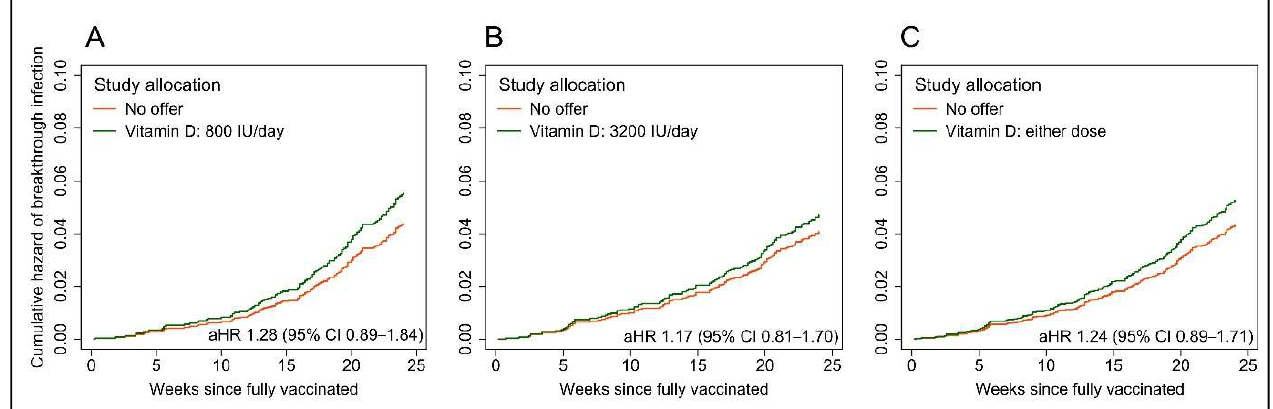
Figure 3. Cumulative hazard plots showing risk of breakthrough SARS-CoV-2 infection by allocation. ( A ), Offer of 800 IU vitamin D3/day vs. no offer. ( B ), Offer of 3200 IU vitamin D3/day vs. no offer. ( C ), Either offer (pooled) vs. no offer. Hazard ratios adjusted for age, sex, educational attainment, frontline worker status, number of people per bedroom, schoolchildren (5–15 years) at home with participant, primary vaccination course, previous SARS-CoV-2 infection, season of first vaccination, inter-dose interval, use of anticholinergics, weekly visits to or from other households, weekly visits to indoor public places other than shops and local weekly SARS-CoV-2 incidence in participants’ area of residence. aHR, adjusted hazard ratio.